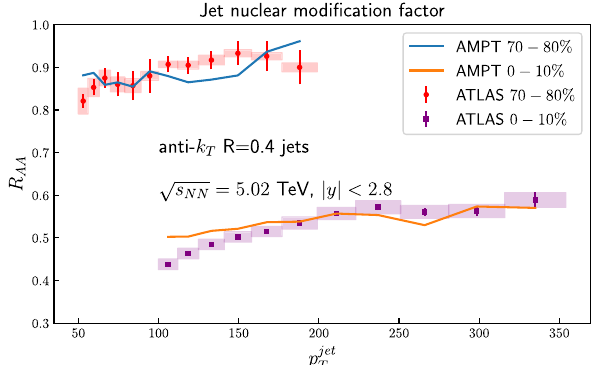
) asafunctionof p jet from T T